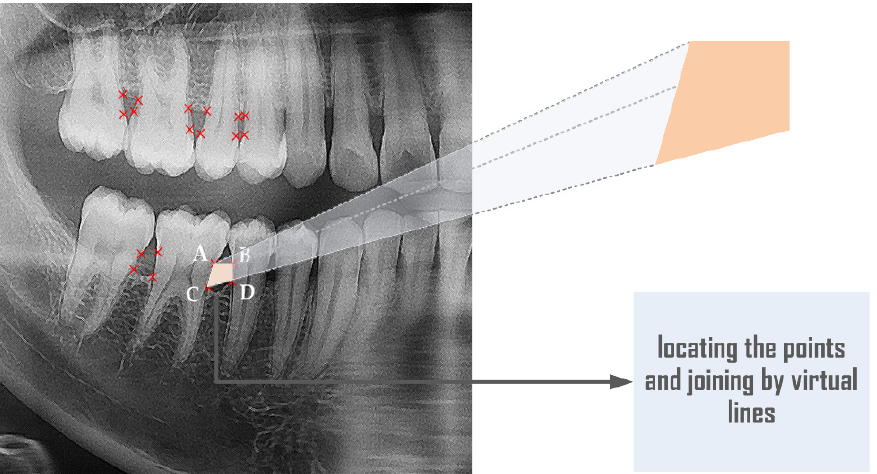
Figure 3. Alveolar space area that is obtained following localization of points on the alveolar crest line and on the CEJ between the adjacent teeth.